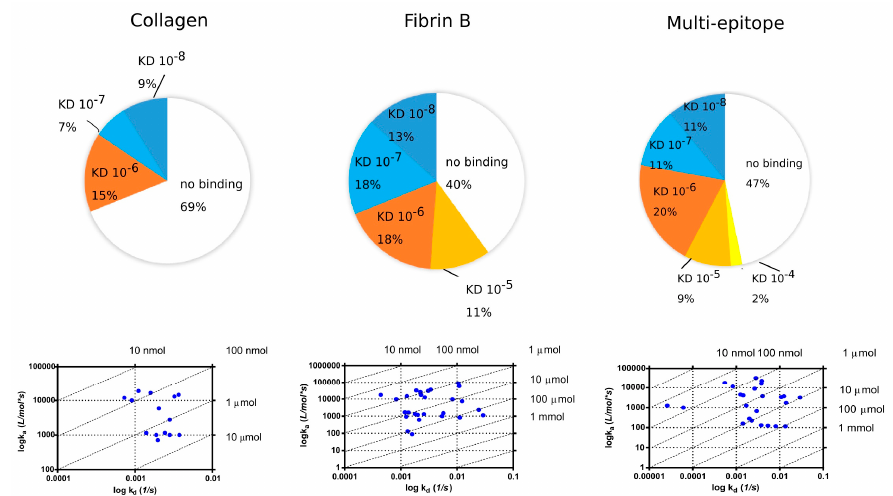
Figure 6. Distribution of apparent K D values measured from RA sera on biotinylated Cit-collagen II, Cit-fibrin β and multi-epitope peptides immobilized on NLC chip. When the biotinylated peptides were immobilized on the NLC chip, 31% of selected RA sera bound to Cit-collagen peptide with apparent K D of 10 − 6 –10 − 8 M, while 60% of sera bound to the Cit- fibrin β peptide with 10 − 5 –10 − 8 M. Interestingly, although a lower proportion of sera (53%) showed binding to the multi-epitope peptide immobilized on the NLC chip, among those which bound, a larger proportion showed higher apparent K D (10 − 8 M).